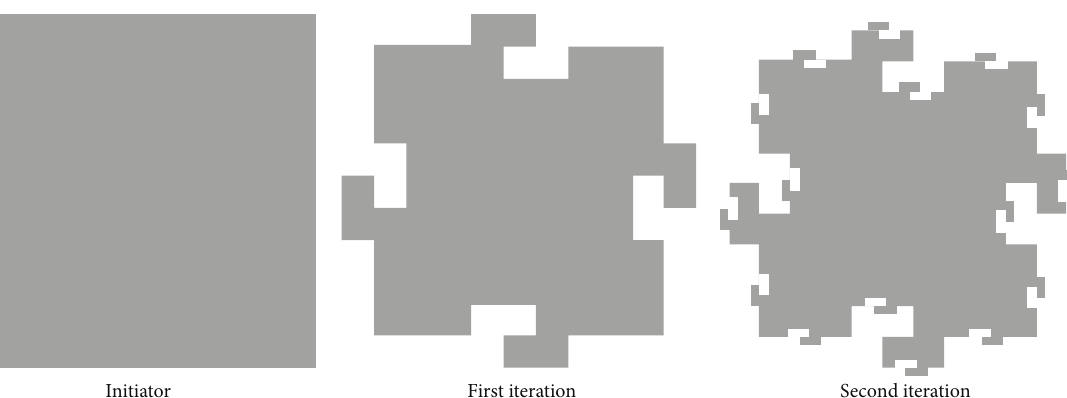
Figure 2: The Giuseppe Peano fractal patch.